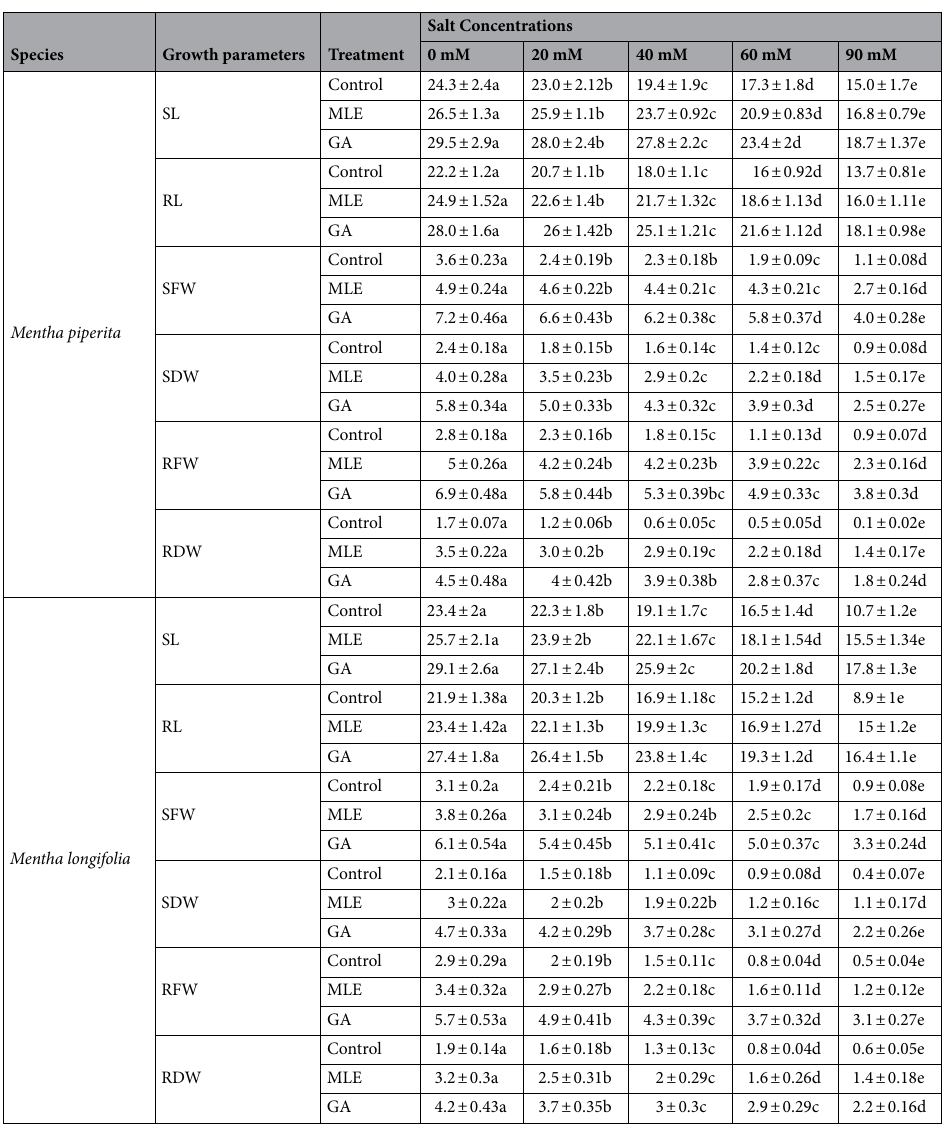
Table 1. Effect of MLE ( Moringa oleifera ) and GA ( Ulva intestinalis ) on growth parameters in the Mentha species seedlings under salt stress (0 mM,20 mM, 40 mM,60 mM, 90 mM). The data displayed are the means (± SE) of three replicates, and bars of dissimilar letters differ significantly at the p ≤ 0.05 level. MLE Moringa leaf extract, GA green algae, SL shoot length, RL root length, SFW shoot fresh weight, SDW shoot dry weight, RFW root fresh weight, RDW root dry